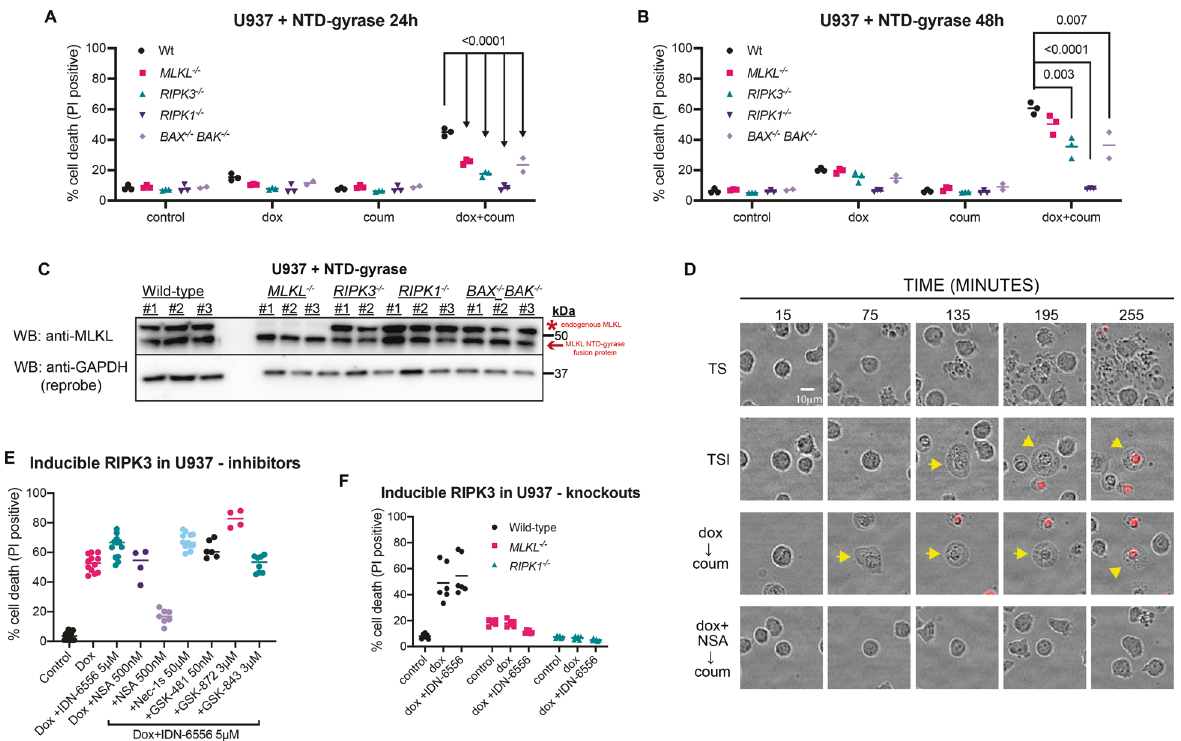
Fig. 4 RIPK1 impacts cell death downstream of MLKL activation. A , B U937 cell lines of various genotypes expressing an inducible MLKL(1-180)-gyrase fusion were treated with doxycycline (to induce expression) and/or coumermycin (to induce dimerisation), or left untreated. After 24 h ( A ) or 48 h ( B ), cells were harvested and assessed for cell death (PI uptake measured using fl ow cytometry), counting a minimum of 5000 cells. Data represent three independent experiments, with the exception of the BAX − / − BAK − / − cell lines, where n = 2. Statistics were calculated in GraphPad Prism 8, and p values are shown where <0.05. C The same U937 cells used in panel A and B were treated with doxycycline alone and left overnight. After approximately 16 h, cells were harvested and lysed for analysis of fusion protein expression via western blot. The upper MLKL band (*) represents endogenous MLKL, and the lower band (arrow) represents the MLKL (1-180) -gyrase fusion protein. D Wild-type U937 were treated with TNF (100 ng/ml), Smac-mimetic (0.5 µM), and caspase inhibitor IDN-6556 (emricasan; 5 µM) (TSI) to induce necroptosis or TNF and Smac-mimetic (TS) alone to induce apoptosis. In parallel, MLKL − / − U937 expressing an inducible MLKL (1-180) - gyrase fusion were treated with doxycycline and coumermycin in the presence or absence of necrosulfonamide (NSA). Images were taken at the speci fi ed timepoints using an IncuCyte S3 System to track morphological changes and PI uptake (shown by red). Cells with a necroptotic phenotype (cellular swelling) are indicate with yellow arrows. Three fi elds were examined per well with representative data shown. E Wild- type U937 cells were treated with doxycycline (20 nM) to induce expression of human wild-type RIPK3 in the presence of various cell death inhibitors, as indicated, for 24 h. At the conclusion of the experiment, cells were analysed for PI uptake using fl ow cytometry, with a minimum of 5000 cells counted. Data represent four or more independent experiments. F Wild-type, MLKL − / − and RIPK1 − / − U937 expressing inducible human wild-type RIPK3 were treated with doxycycline (20 nM) and IDN-6556 (5 µM), doxycycline alone, or left untreated. After 24 h, cell death was measured as PI uptake using fl ow cytometry. Data are a summary of six independent